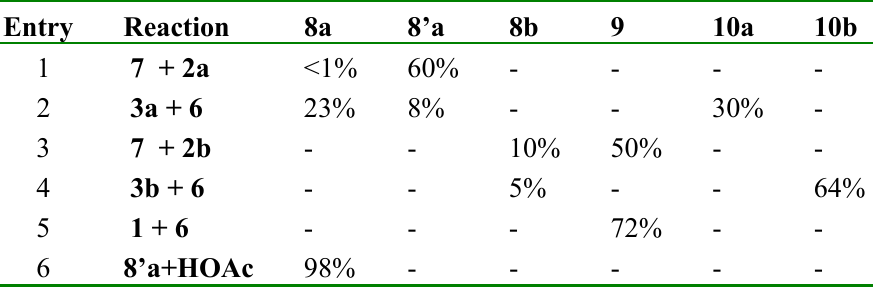
Table 1. Yields of prepared compounds.